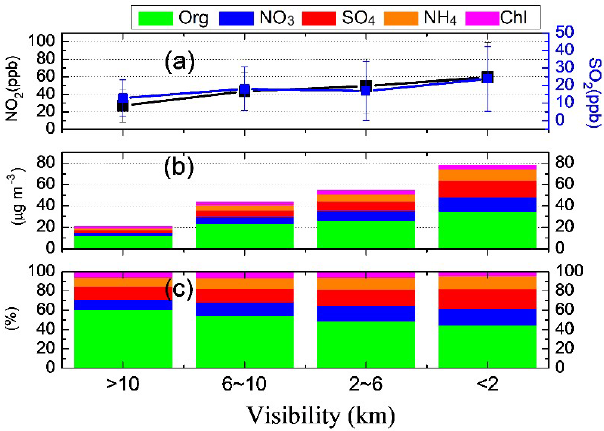
Figure 5. Variation of (a) NO 2 , SO 2 , (b) chemical composition and (c) mass fraction of organic aerosol, nitrate, sulfate, ammonium and chloride with decreased visibility during the intensive campaign in